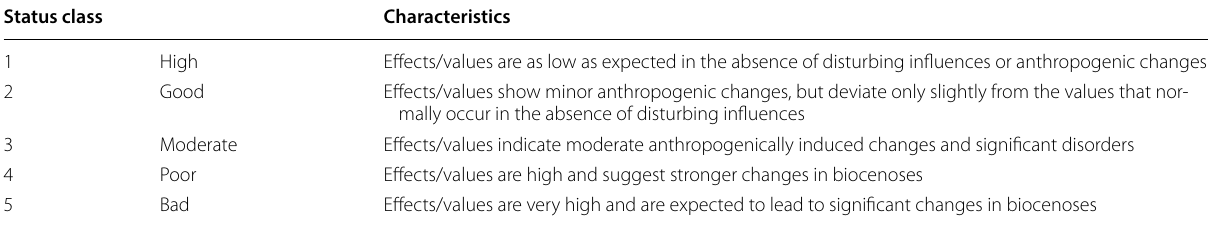
Table 1 Definition of ecotoxicological status classes according to Duft and Oehlmann